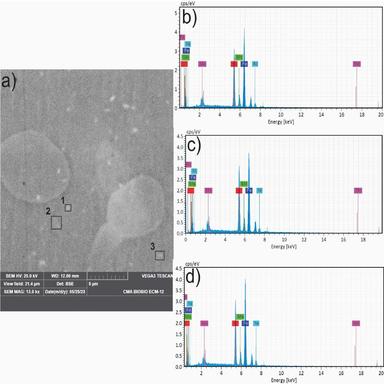
SEM-BSE images of SDSS-Nb without etching, a) SDSS-Nb heat-treated at 1030 ◦C; b) EDS spectrum of σ phase in SDSS-Nb heat-treated at 1030 ◦C zone (1); c) EDS spectrum of σ phase in SDSS-Nb heat-treated at 1030 ◦C zone (2); d) EDS spectrum of σ phase in SDSS-Nb heat-treated at 1030 ◦C zone (3).